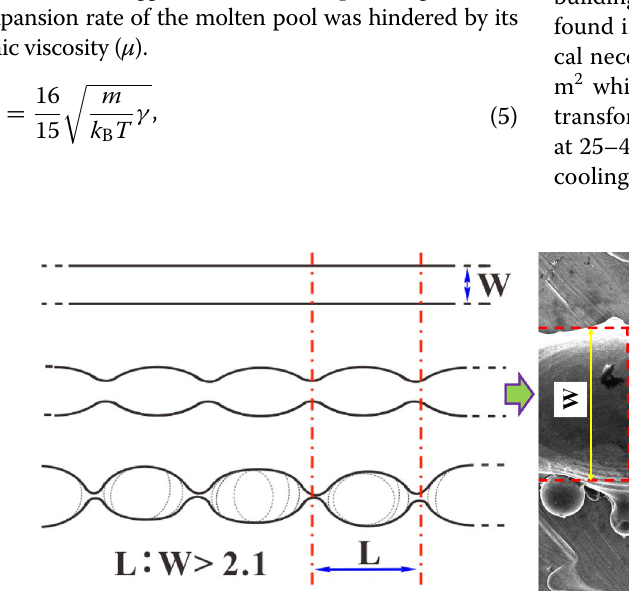
Figure 16 Rayleigh instability morphology of deposited tracks